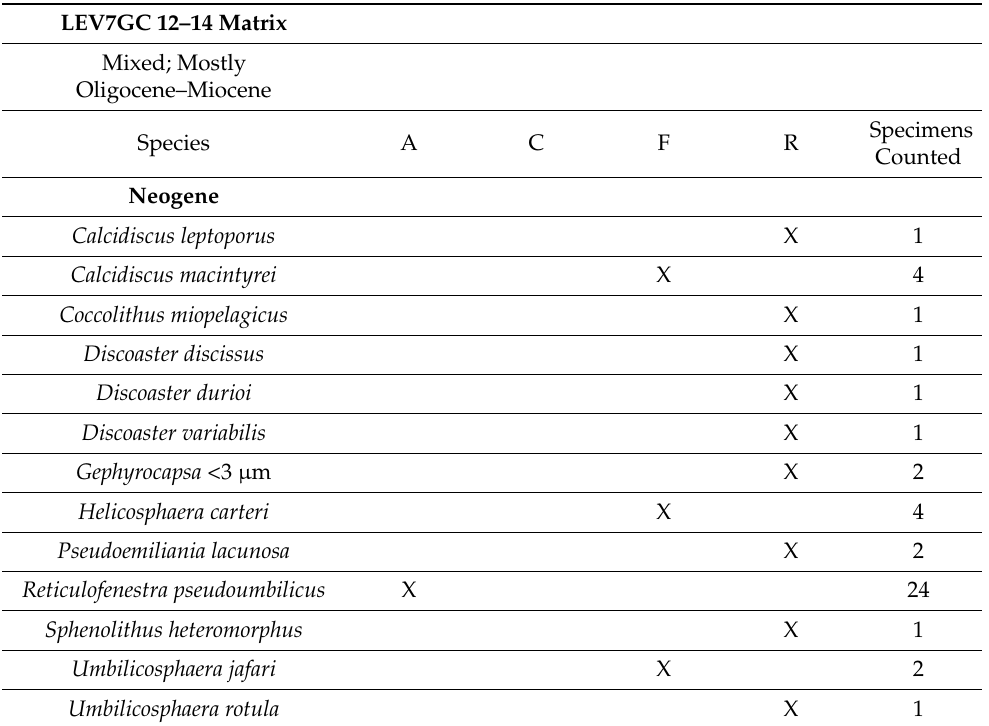
Table A29. Milano